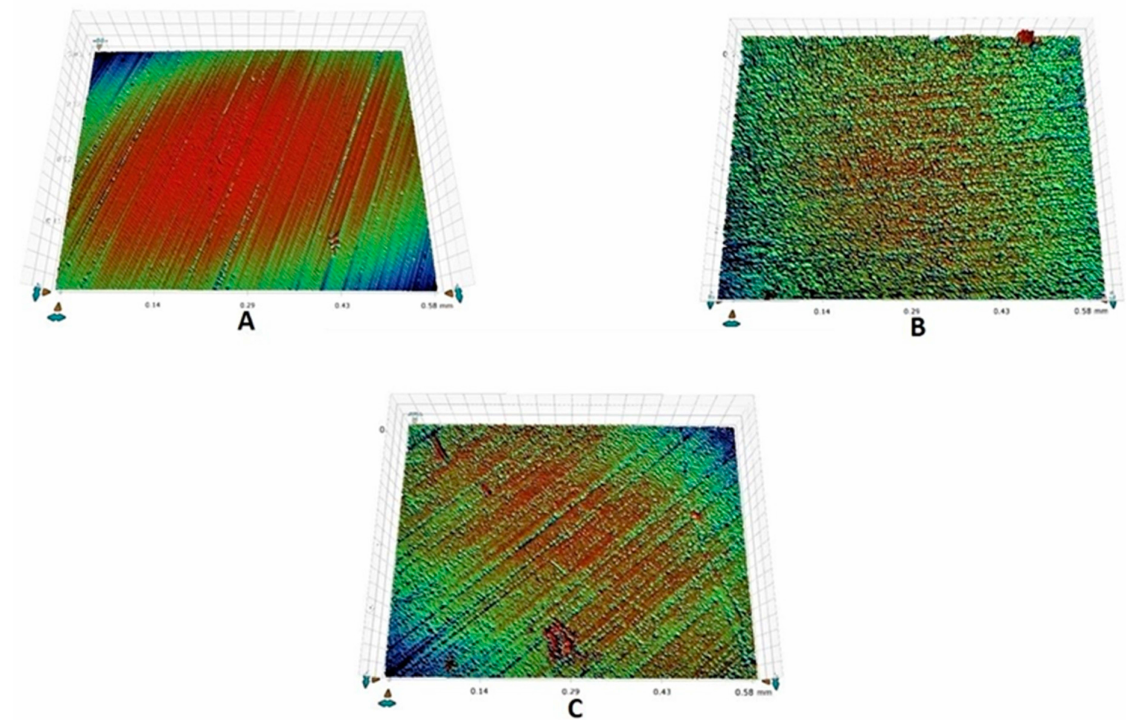
Figure 4. Representative enamel surface roughness profilometric images belonging to group 3 showing: ( A ) ground and polished enamel surface at baseline, ( B ) rough enamel surface post-demineralization, ( C ) remineralized enamel surface after brushing.